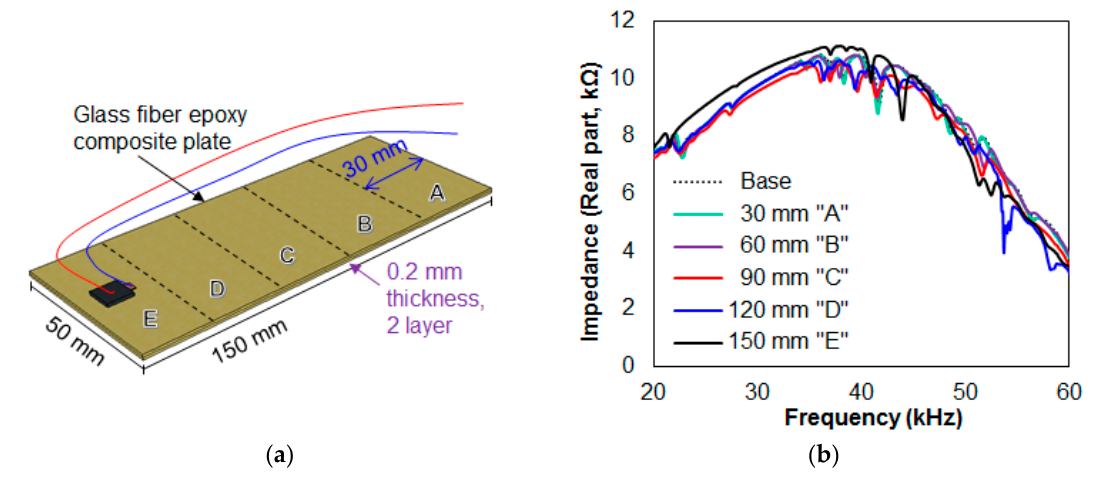
Figure 2. ( a ) First debonding test scenario; ( b ) results from the first debonding test.